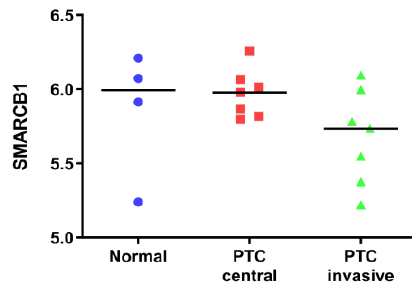
Figure 1. SMARCB1 gene expression levels from a published dataset (GSE6004) in normal thyroid tissues, tumor centers of papillary thyroid cancer (PTC), and invasive areas of PTC. Data are reported as scatter plots of log 2 values and medians.